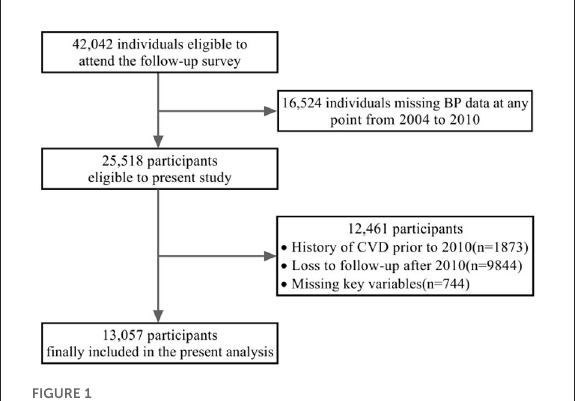
FIGURE1 The flowchart for the study design and